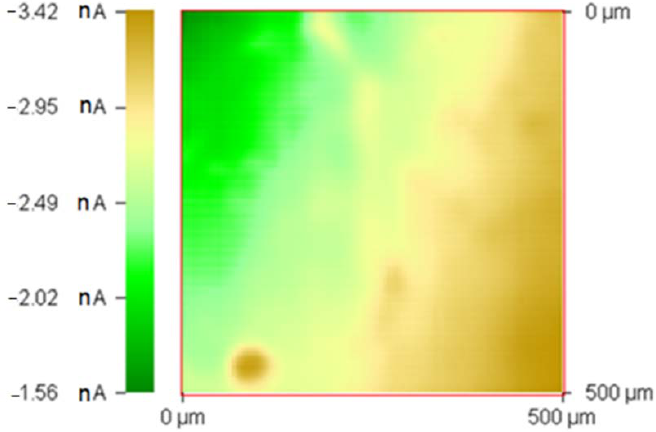
Figure 10. SECM image in a droplet of 0.5 M K 2 SO 4 containing 1 mM FcOH as redox mediator. The tip of the microelectrode was kept at 0.6 V to have a steady state current at the tip.